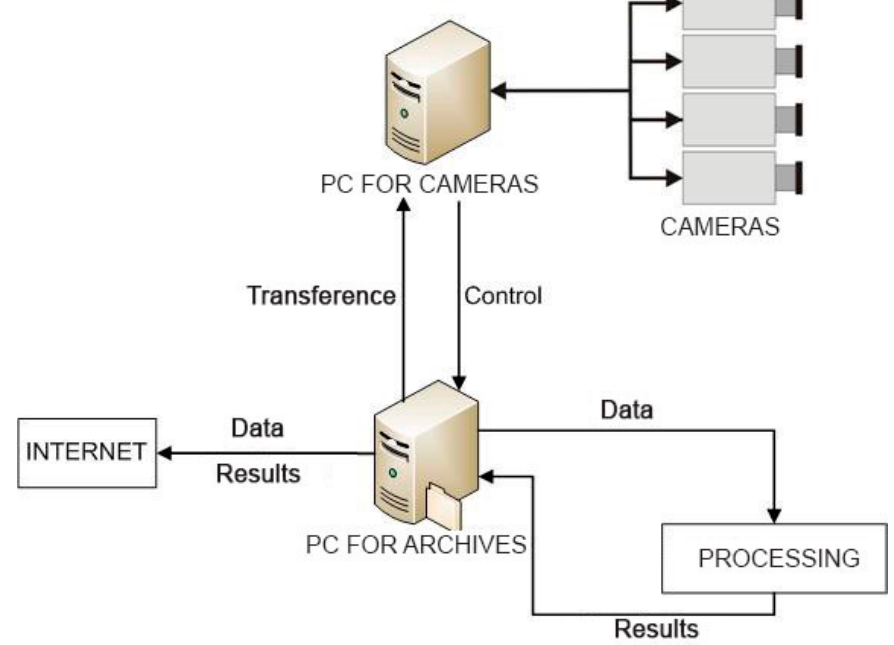
Figure 2. Configuration of HORUS type video monitoring system.